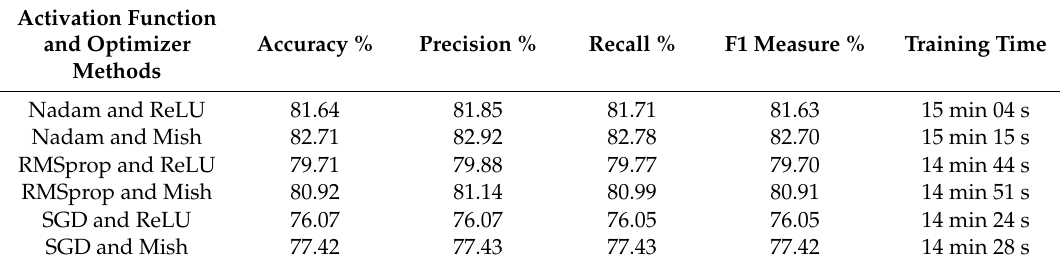
Table 6. The e ff ectiveness of AlexNet with ReLU and Mish combined with other optimizers. Activation Function and Optimizer